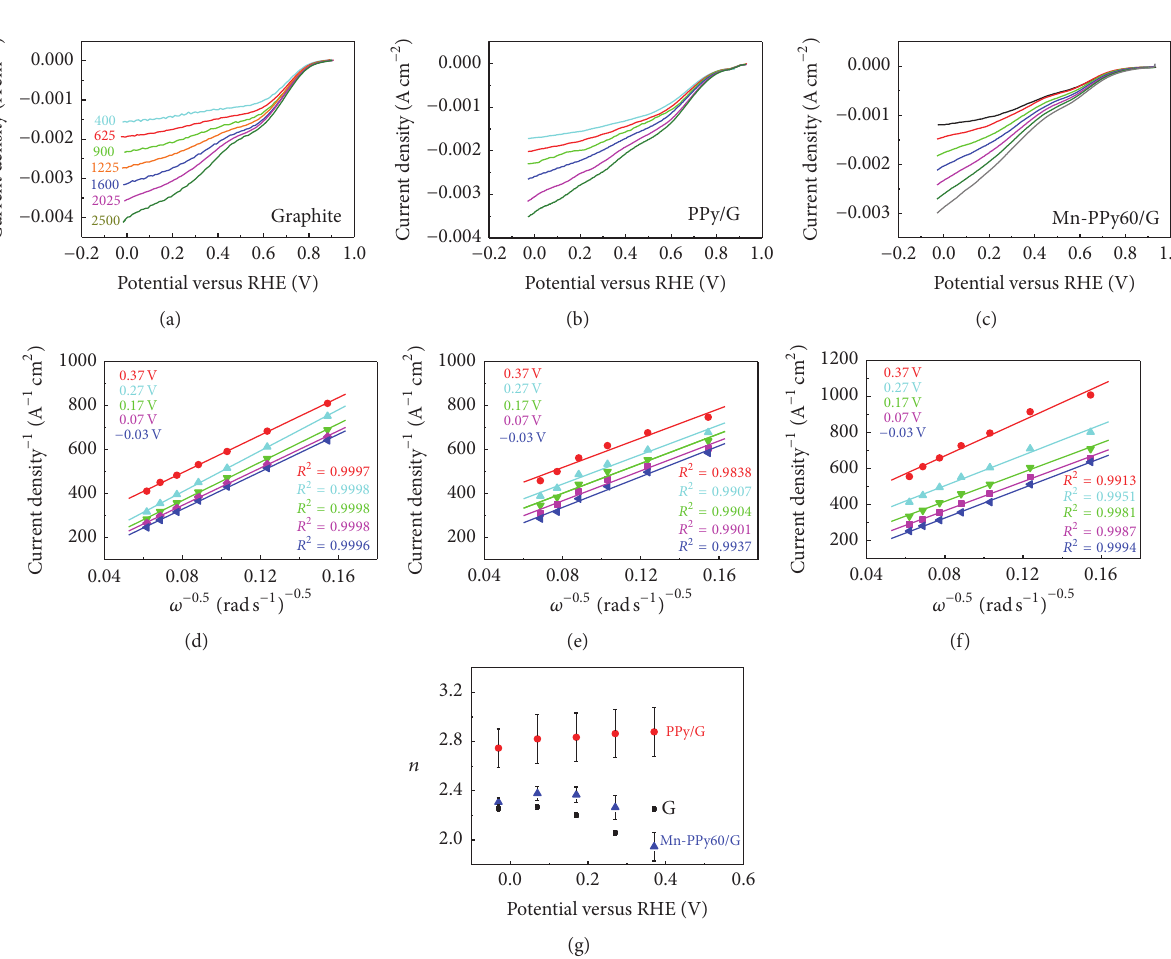
Figure 9. The Koutecky–Levich plots and the correspondent 𝑛 values at selected potentials (Figures 9(b) and 9(c)) indicate that 4𝑒 − oxygen reduction process is favoured similarly